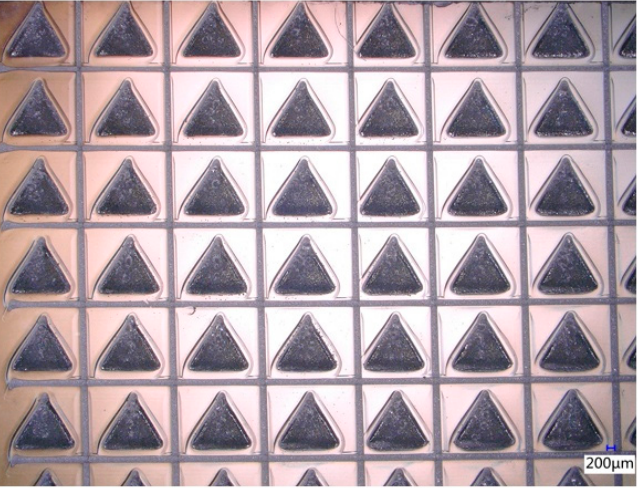
Figure 21. Morphology diagram of square-column triangle secondary microstructures.